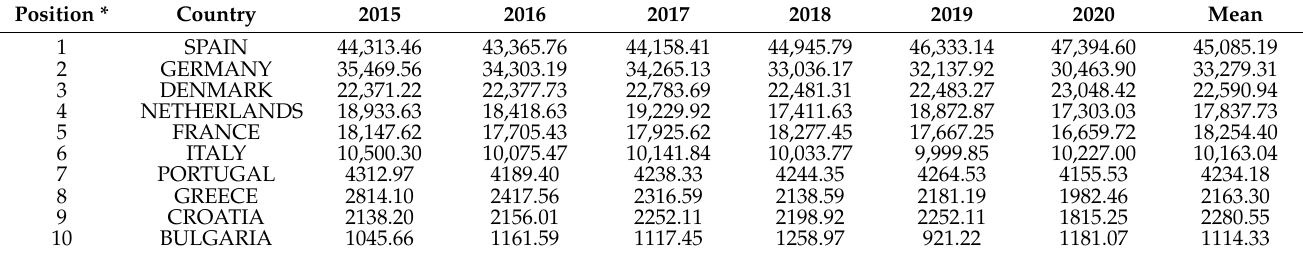
Table 5. Results of N 2 O emissions from manure management using Tier 1 methodology (Gg CO 2 - eq/year).